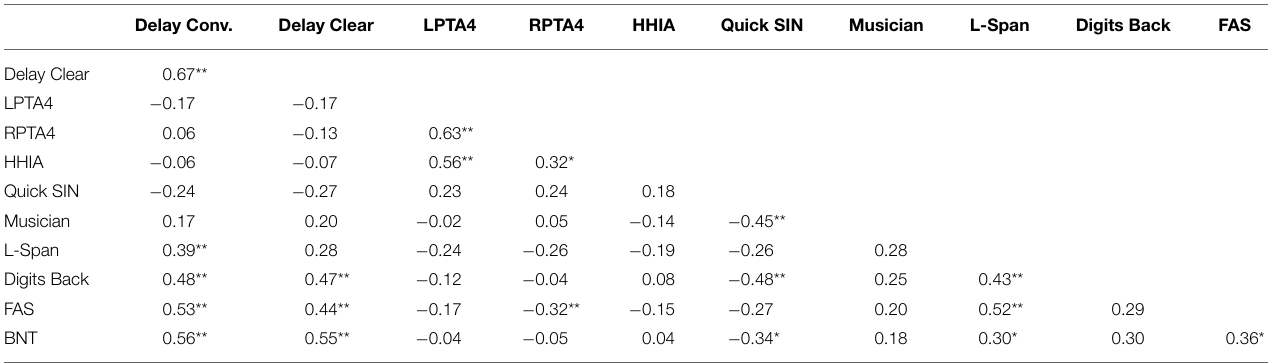
TABLE 8 | Correlation analysis between delayed memory performance in the conversational (conv.) and clear listening conditions and hearing and cognitive abilities–Both groups. Delay Conv.